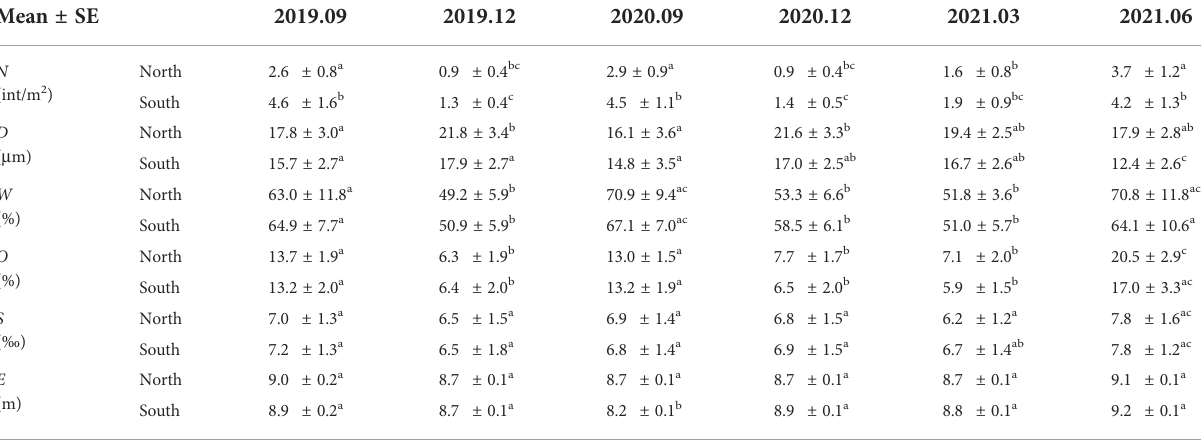
Different superscript letters indicate signi fi cant differences between different cases (P<0.05).